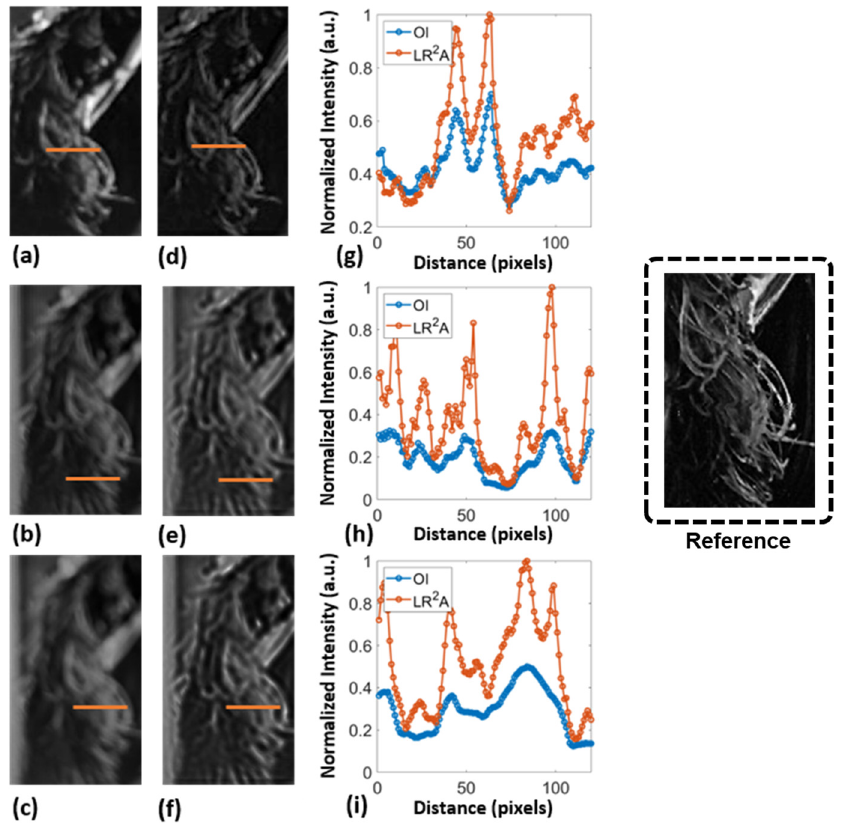
Figure 7. Images recorded using a smartphone ( a ) using a Samsung Galaxy A7 ( b , c ) using a Oneplus Nord 2CE with di ff erent point sizes of (0.4 and 0.5 cm). ( d – f ) are corresponding LR 2 A deblurred images. Line data (orange line) from the cropped images were plo tt ed and given in ( i – h ).